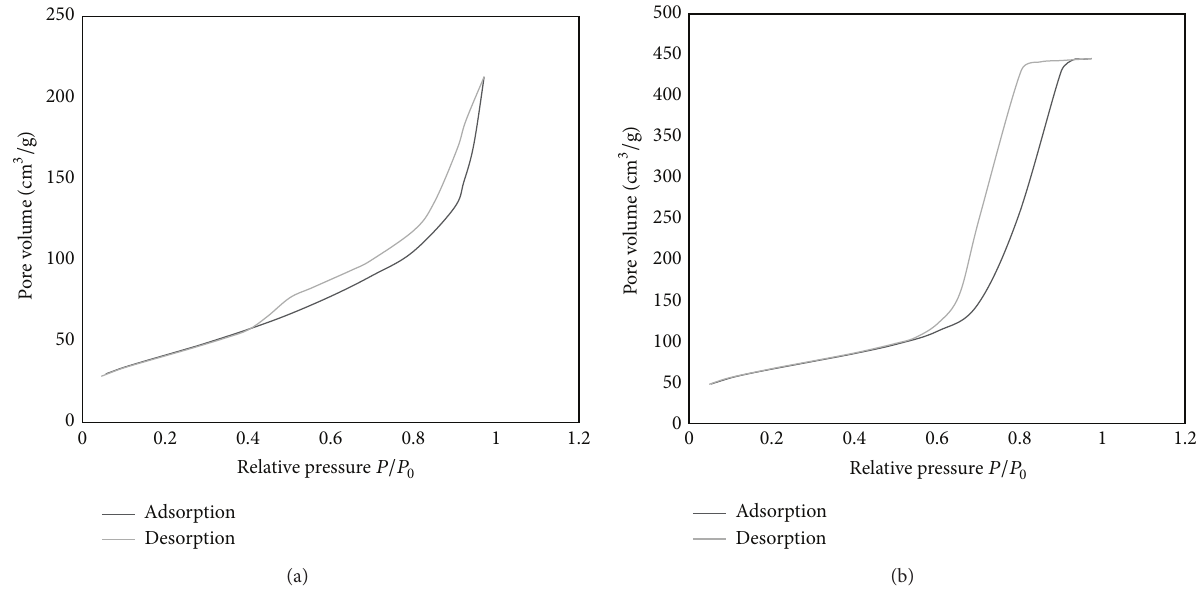
Figure 1: N 2 adsorption/desorption isotherm of (a) florisil and (b) silica.